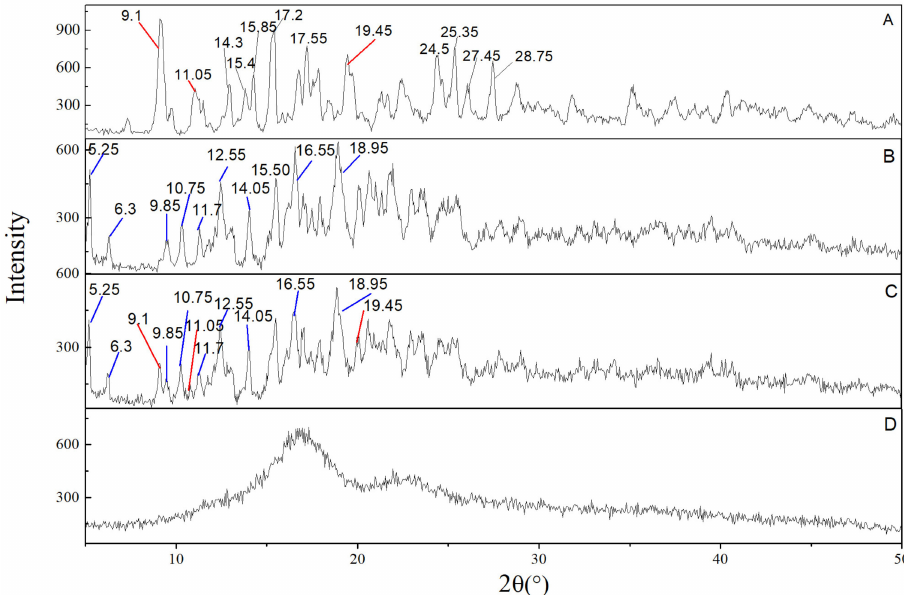
Figure 5. X-ray diffractograms of G-Re ( A ), γ -CD ( B ), G-Re- γ -CD PM ( C ), and G-Re- γ -CD IC ( D ). Red lines point to the characteristic peak of G-Re and blue lines point to the characteristic peak of γ -CD.